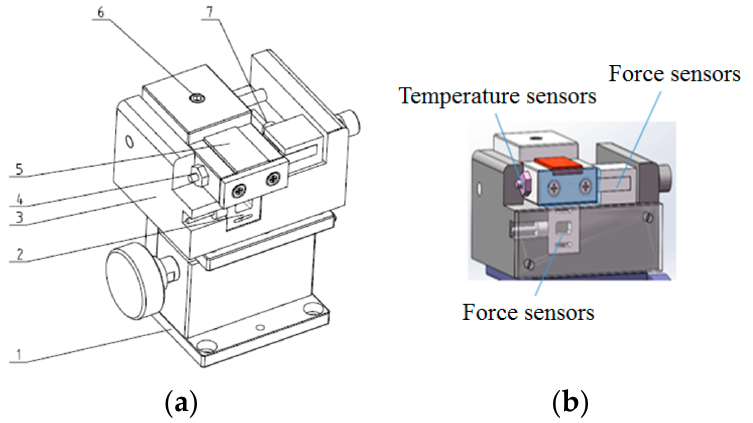
Figure 8. Adjustable precision measuring stage and sample-loading mechanism: ( a ) overall view and ( b ) partial enlargement. 1—manual fine adjustment of the lift; 2,7—force sensors; 3—sample-loading mechanism; 4—temperature sensors; 5—samples tested; 6—fastening screws.